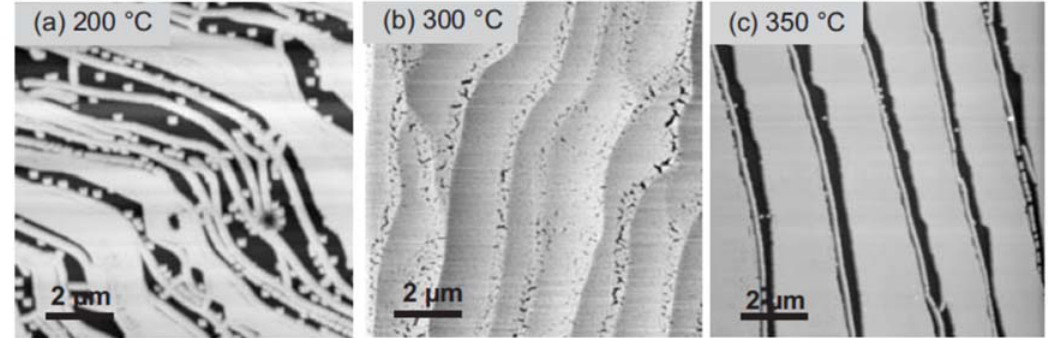
Figure 4. AFM images of Al 2 O 3 grown directly on the pristine EG surface by 500 thermal ALD cycles of TMA/water (i.e., 50 nm Al 2 O 3 ) at different temperatures: ( a ) 200 °C, ( b ) 300 °C and ( c ) 350 °C. Images adapted with permission from Ref. [38], copyright Wiley 2010.